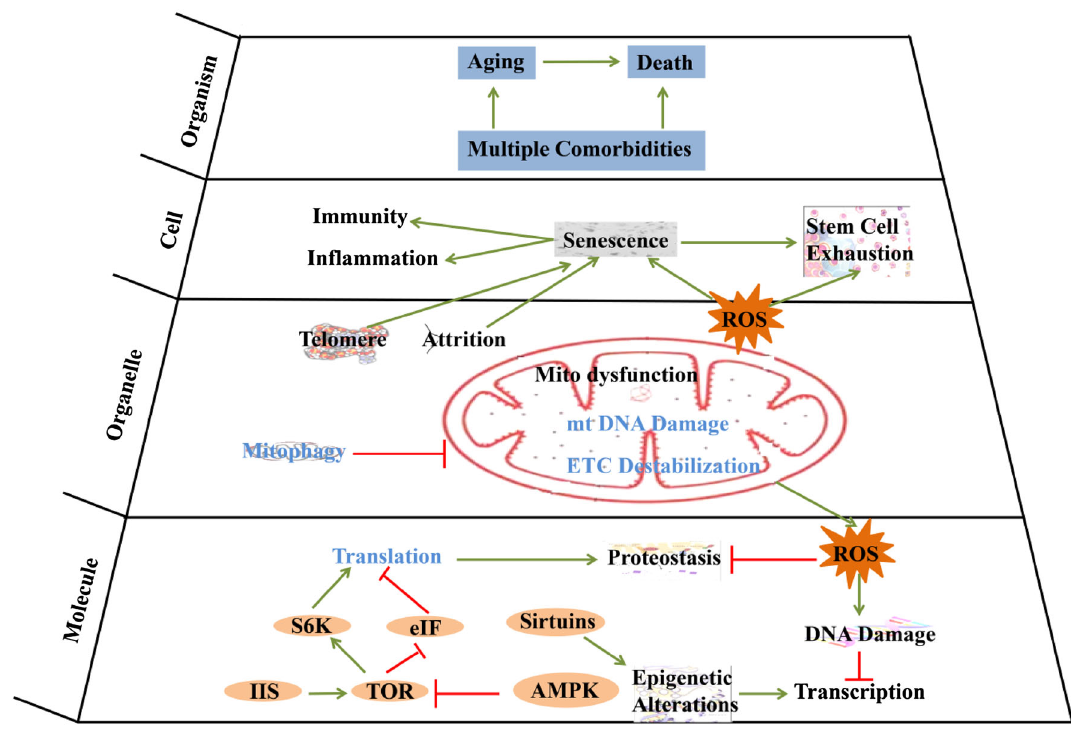
Fig. 1 Aging mechanisms in different